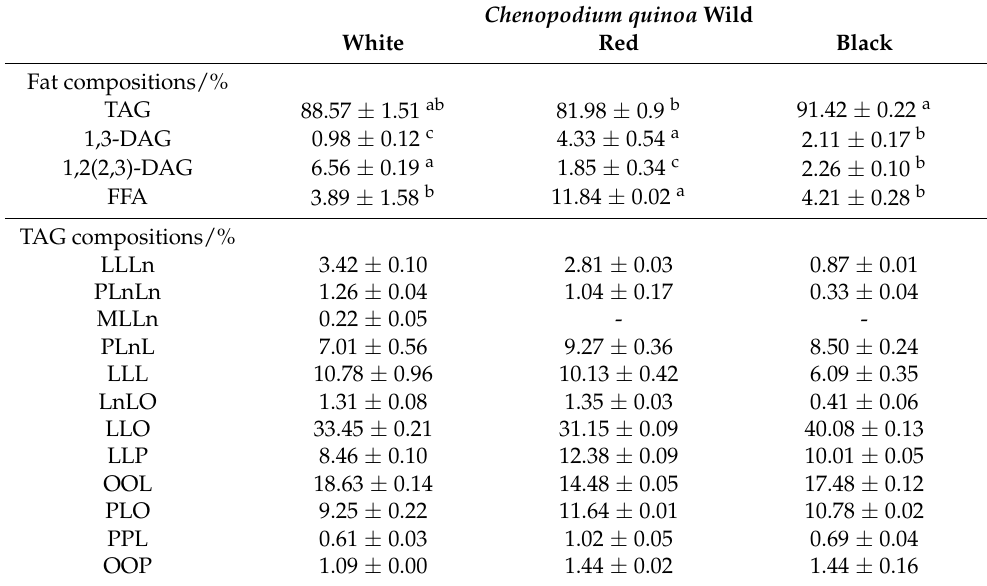
Table 2. Comparisons of Fat, TAGs, Tocopherols, and Phytosterols of three types of Chenopodium quinoa Wild seed